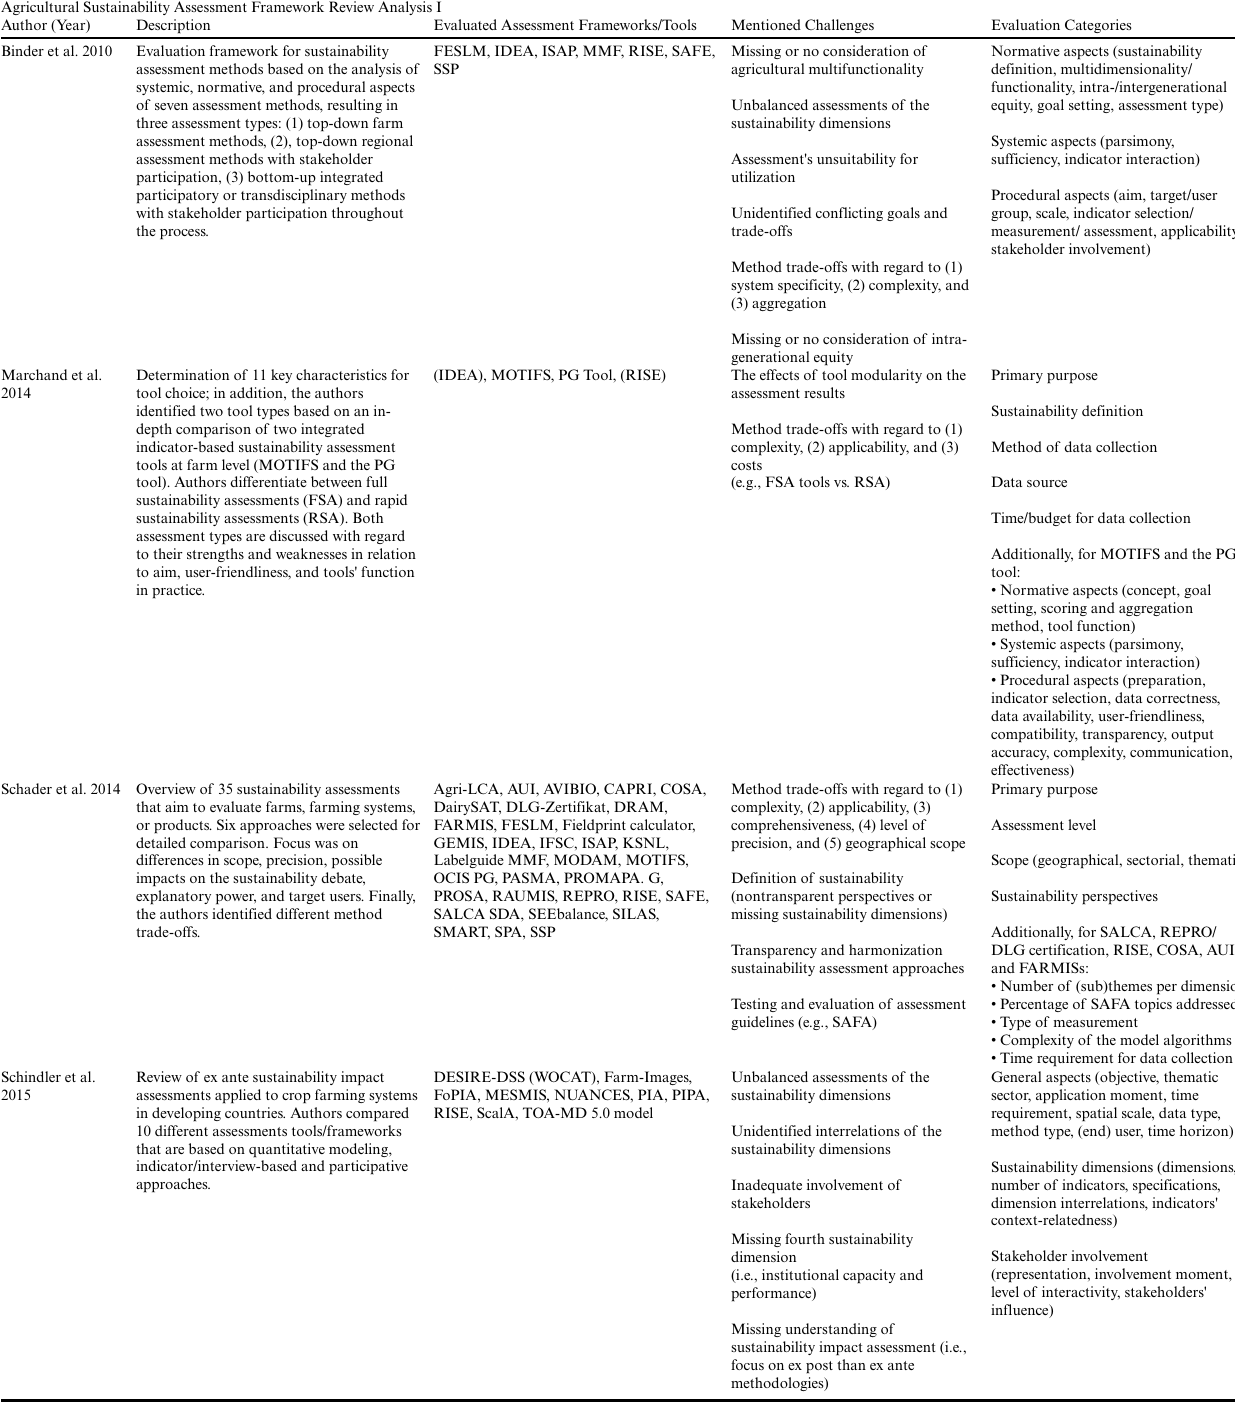
Table 1 . Review analysis I. Evaluation criteria of the analysis of agricultural sustainability assessment framework reviews were the review objective, the evaluated assessment frameworks/tools, the mentioned challenges, and the evaluation